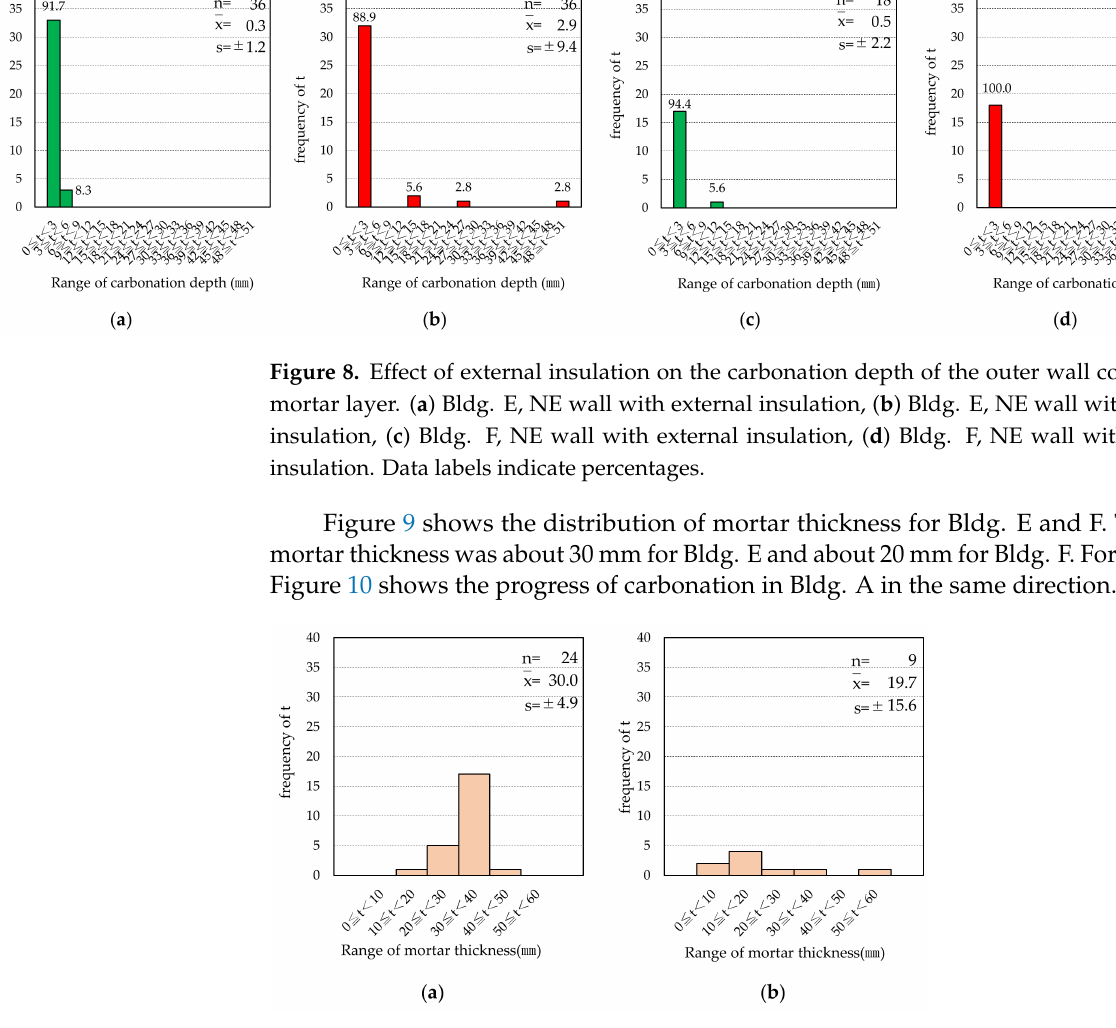
Figure 9. Distribution of mortar thickness. ( a ) Bldg. E, ( b ) Bldg.